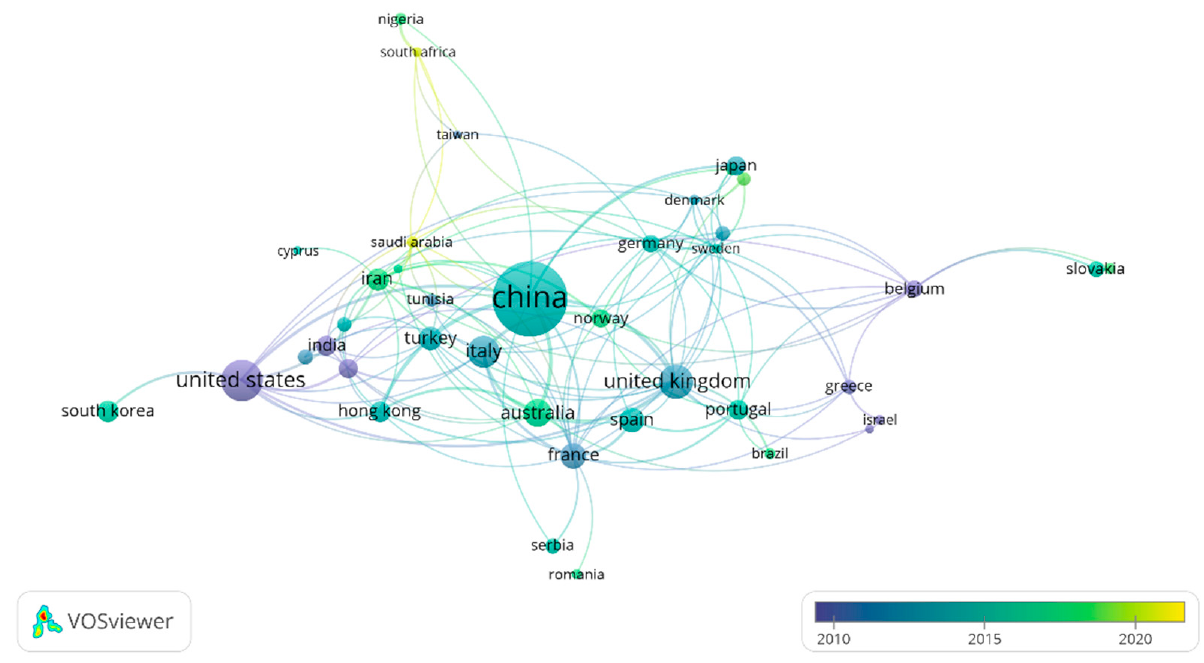
Figure 23. Co-authorship network of countries . The main indicators characterizing the relevance of the topic in the scientific commu- nity are presented in Table